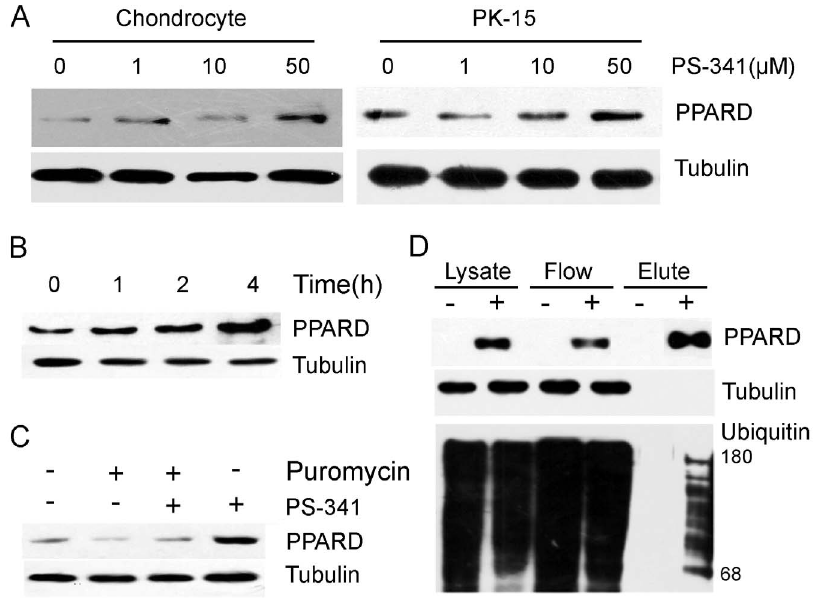
Figure 4. sPPARD turnover is controlled by ubiquitin-proteasome system. (A) Chondrocyte and PK-15 cells were treated with PS341 at 4 different concentrations for 4 h, and sPPARD levels were detected by Western blot. (B) PK-15 cells were treated with 10 m M PS341 and sPPARD levels were detected by Western blot at four time points after the treatment. (C) PK-15 cells were treated with puromycin, puromycin and PS341, or PS341 alone for 4 hours and sPPARD levels were detected by Western blot. (D) HEK293T cells were transfected with HA-ub vector along with pcDNA4A-His or –sPPARD expression vectors and after 24 hours were incubated with 10 m M PS341 for 4 hours. His-tagged sPPARD was pulled down with nickel affinity gel under denaturing conditions. Expression levels of sPPARD and tubulin in cell lysates are shown below. An arrow and a bar indicate mono- ubiquitinated and poly-ubiquitinated sPPARD, respectively. sPPARD was detected in cell lysate, flow-through, and eluate fractions.